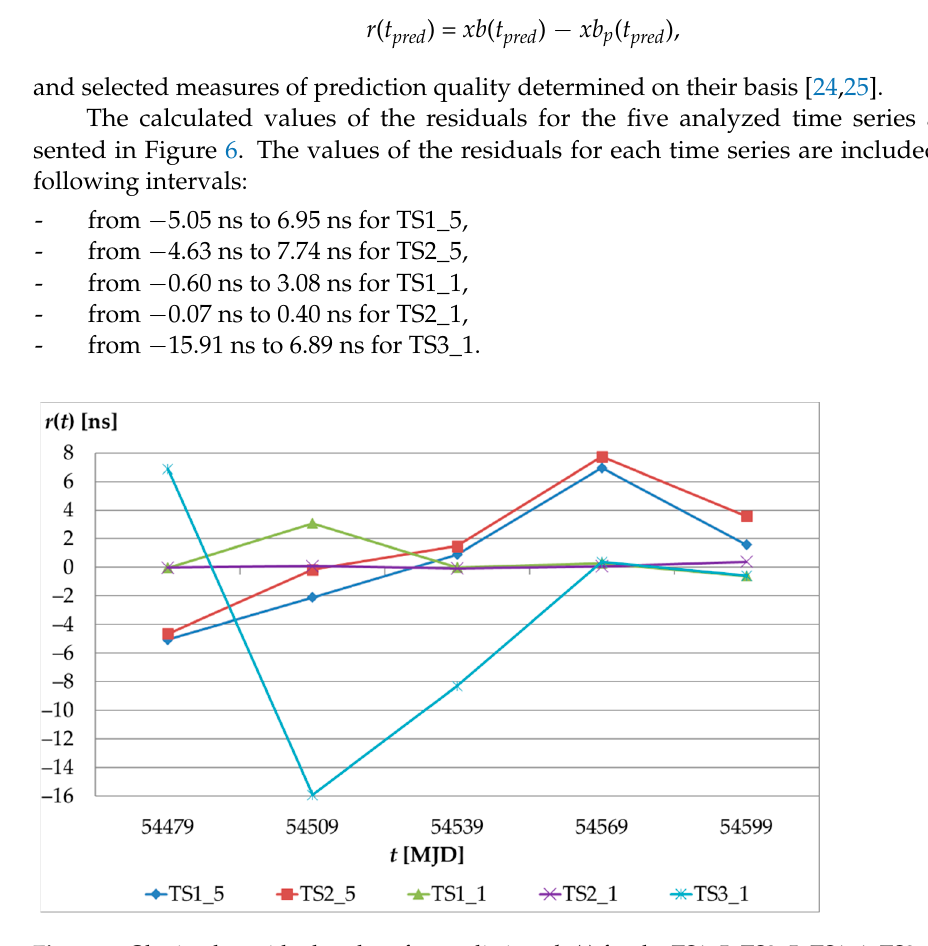
Figure 6. Obtained r residuals values for predicting xb p ( t ) for the TS1_5, TS2_5, TS1_1, TS2_1, TS3_1.